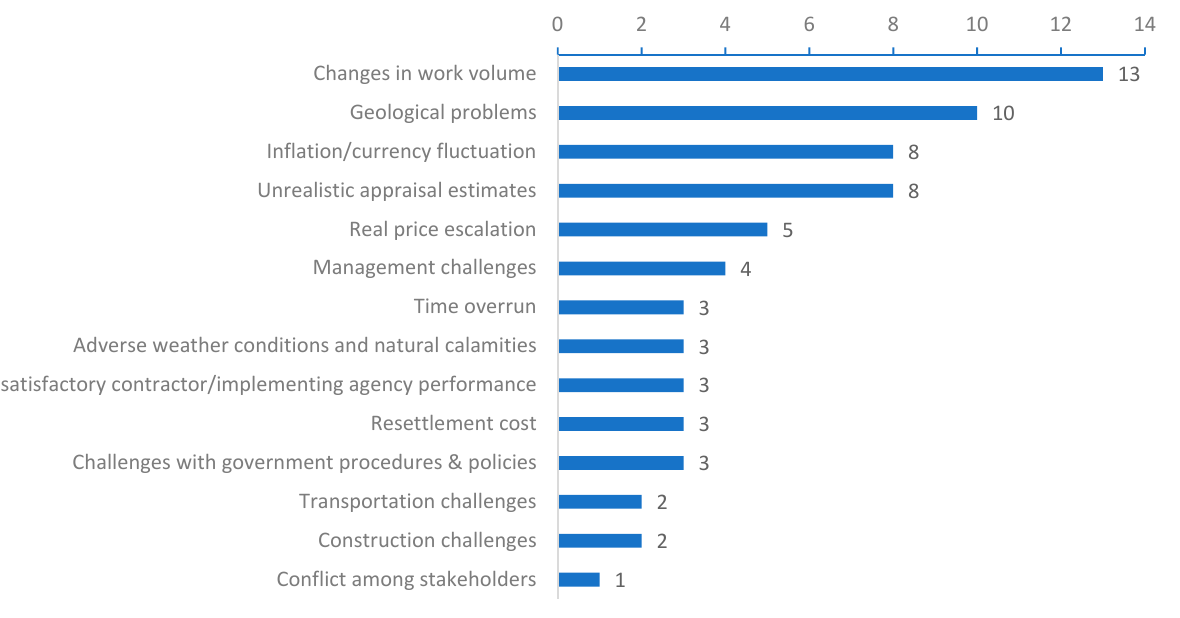
5 Figure 2. Causes of time overruns (summary).